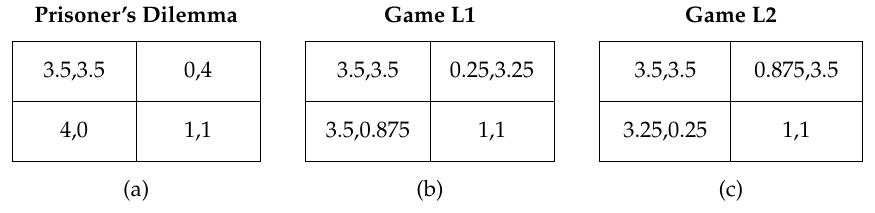
Figure 2. Prisoner’s dilemma and the stage games used in constructing a self-generating